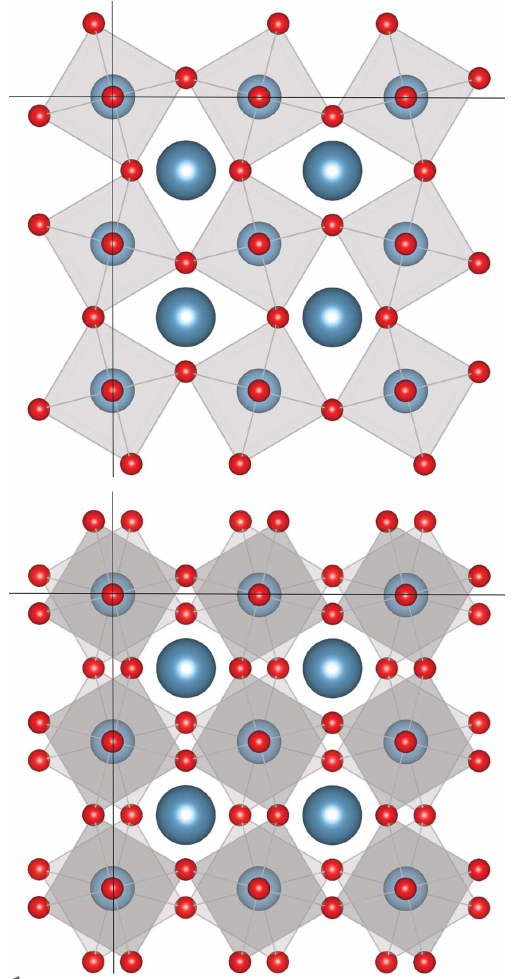
Figure 1 Illustration of in-phase and out-of-phase tilt systems as viewed down the tilt axis. The tilt systems shown here are (cid:2) 0 (cid:2) 0 (cid:4) + (top) and (cid:2) 0 (cid:2) 0 (cid:4) (cid:2)